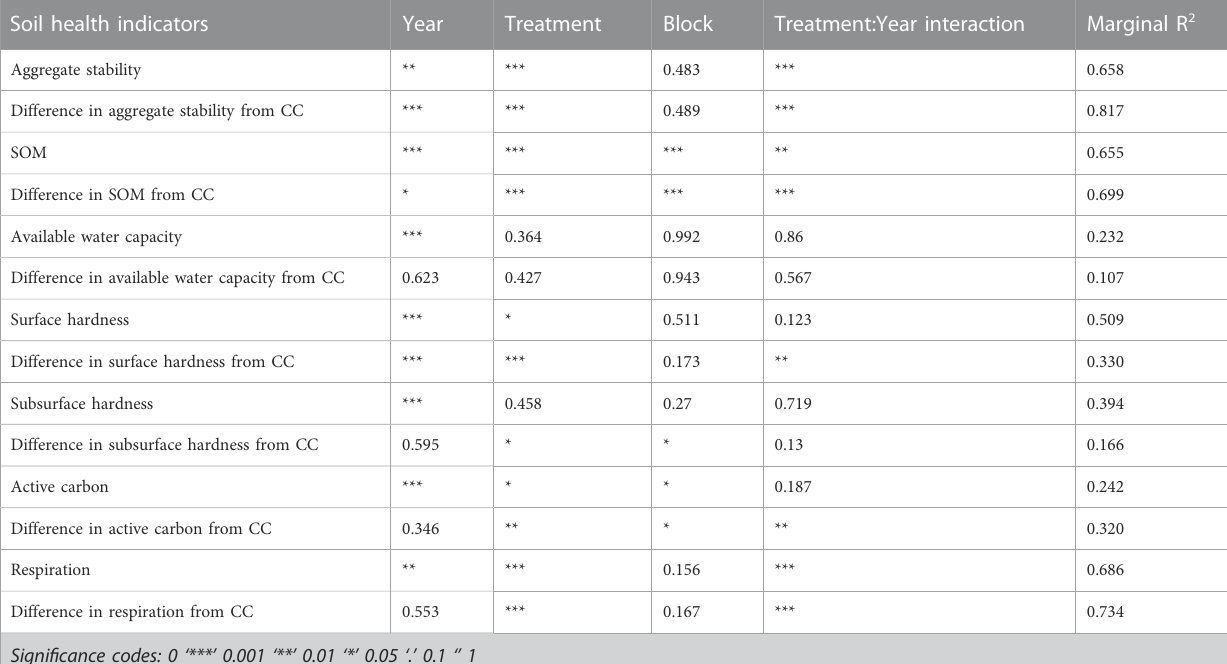
TABLE 2 Signi fi cant in fl uences on soil health parameters; ANOVA p -values and Marginal R2 values of repeated measures linear mixed models of soil health parameters, and the deviance of soil health parameters from continuous corn (CC).